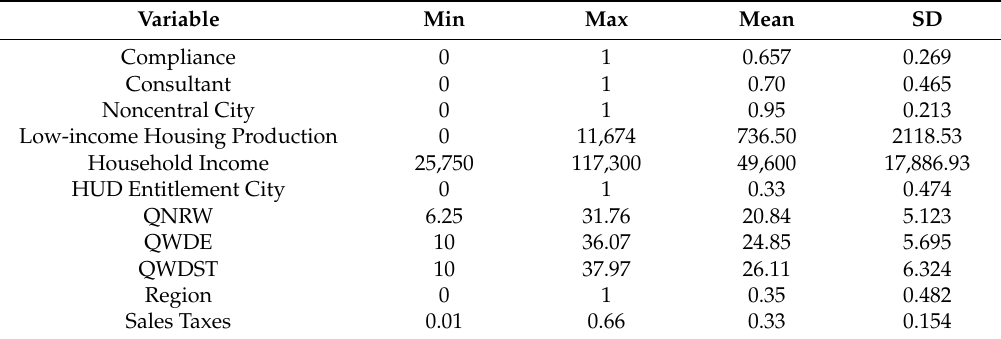
Table 2. Summary statistics of the regression variables, n =